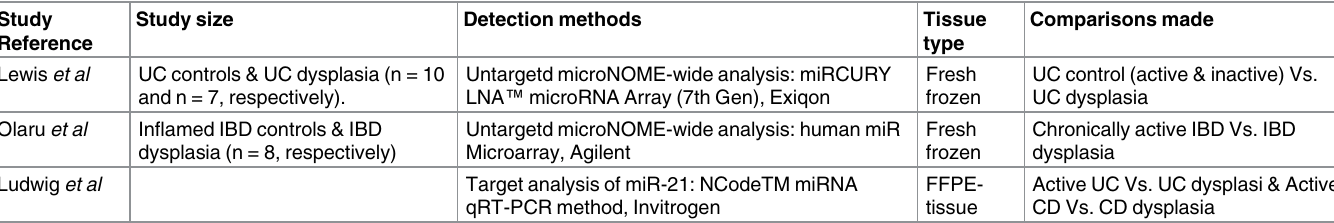
Table 5. Comparison of miRNA studies in IBD